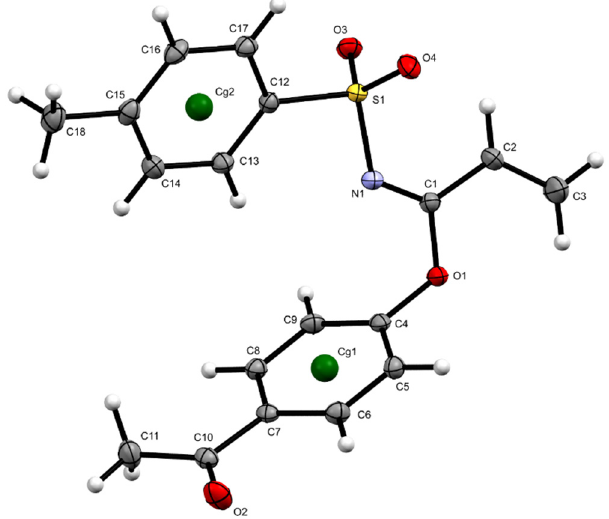
Figure 3. Geometric structures of 3 obtained by X-ray diffraction, displacement ellipsoids are drawn at the 50% probability level.